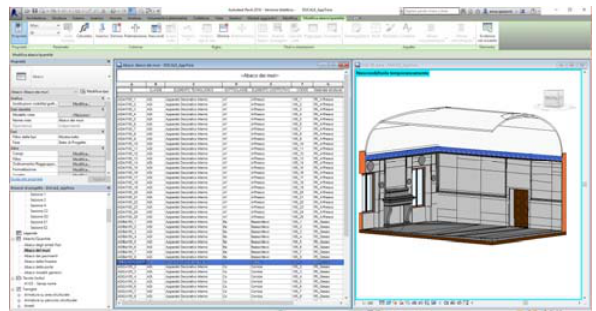
Figure 4: schedule and view of the model. The same element is selected in the schedule and in the